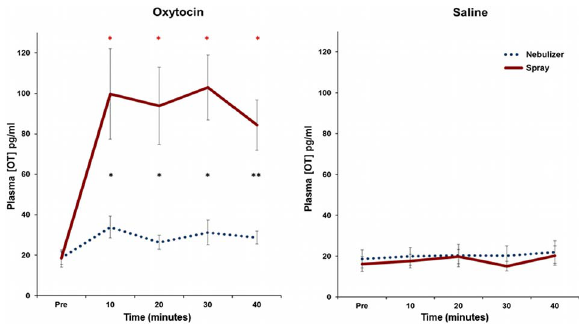
Figure 3. Plasma Oxytocin (OT) concentration. Values shown are the mean 6 SEM (n=15). A. OT concentration in plasma at each time point before and after OT administration. Note that asterisks in black show significant differences between the two delivery methods. Red asterisk indicates significant elevation of OT concentration for each time point relative to baseline for the intranasal spray condition; * p , .05 and ** p , .001. B. OT concentration in plasma at each time point before and after saline